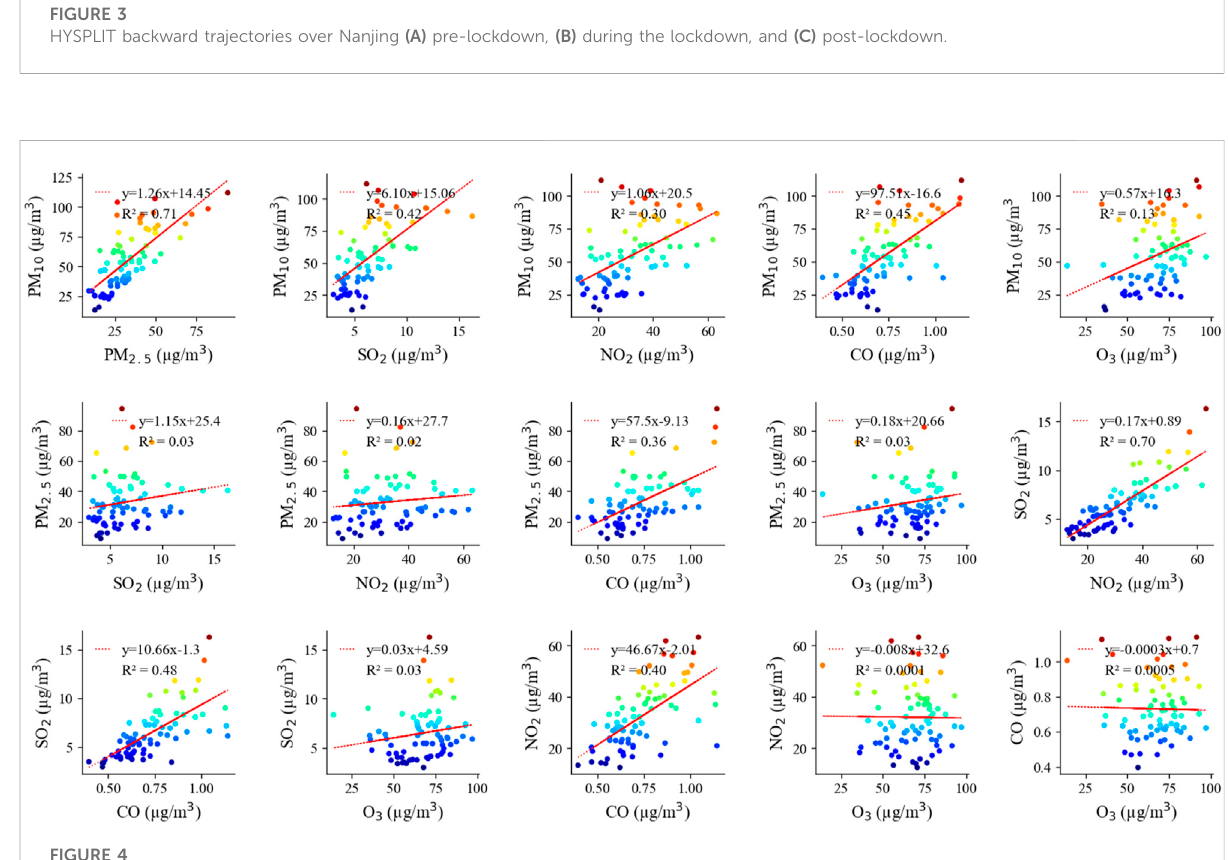
FIGURE 4 Co-relationships between air pollutants during the lockdown period in